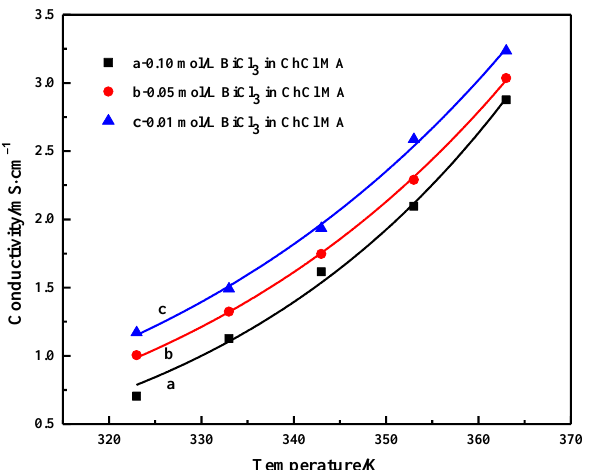
Figure 6. Conductivity of ChCl-MA-BiCl 3 as a function of temperature and concentration of BiCl 3 .